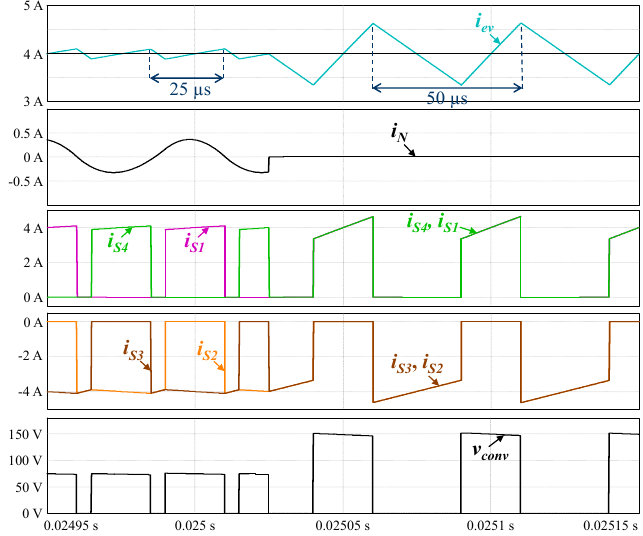
Figure 9. Waveforms of the EV current ( i ev ), dc grid current in the positive wire ( i pos ), currents in the IGBTs S 1 , S 2 , S 3 , S 4 ( i S 1 , i S 2 , i S 3 , i S 4 ), and voltage produced by the dc–dc converter ( v conv ) during the transition from normal operation to operation with a failure in the neutral wire of the bipolar dc